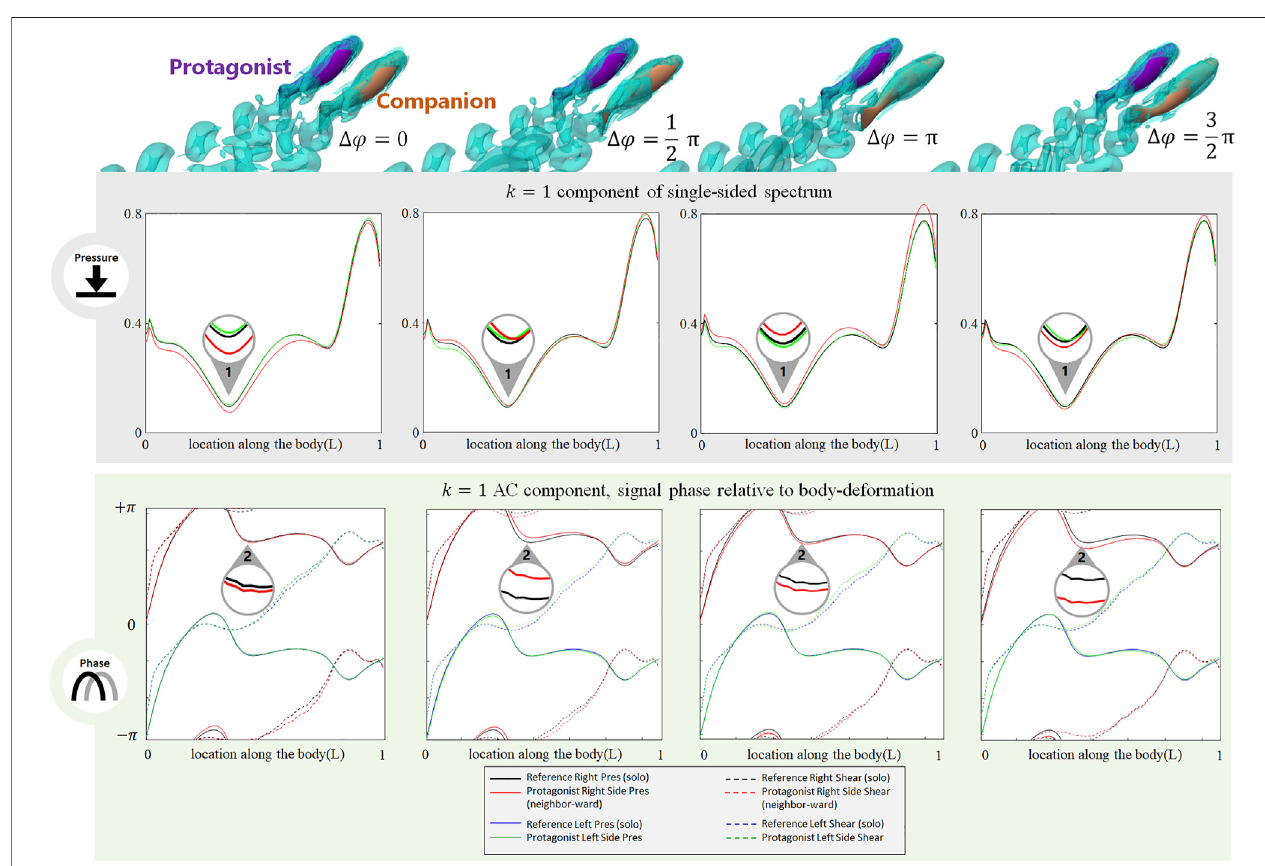
π , π and 3 π . Full results are 2 2